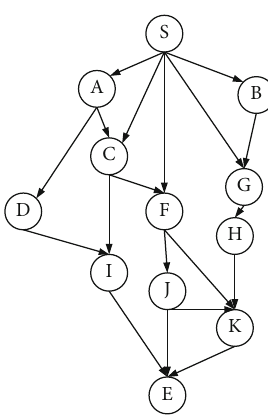
Figure 9: Schematic diagram of directed graph